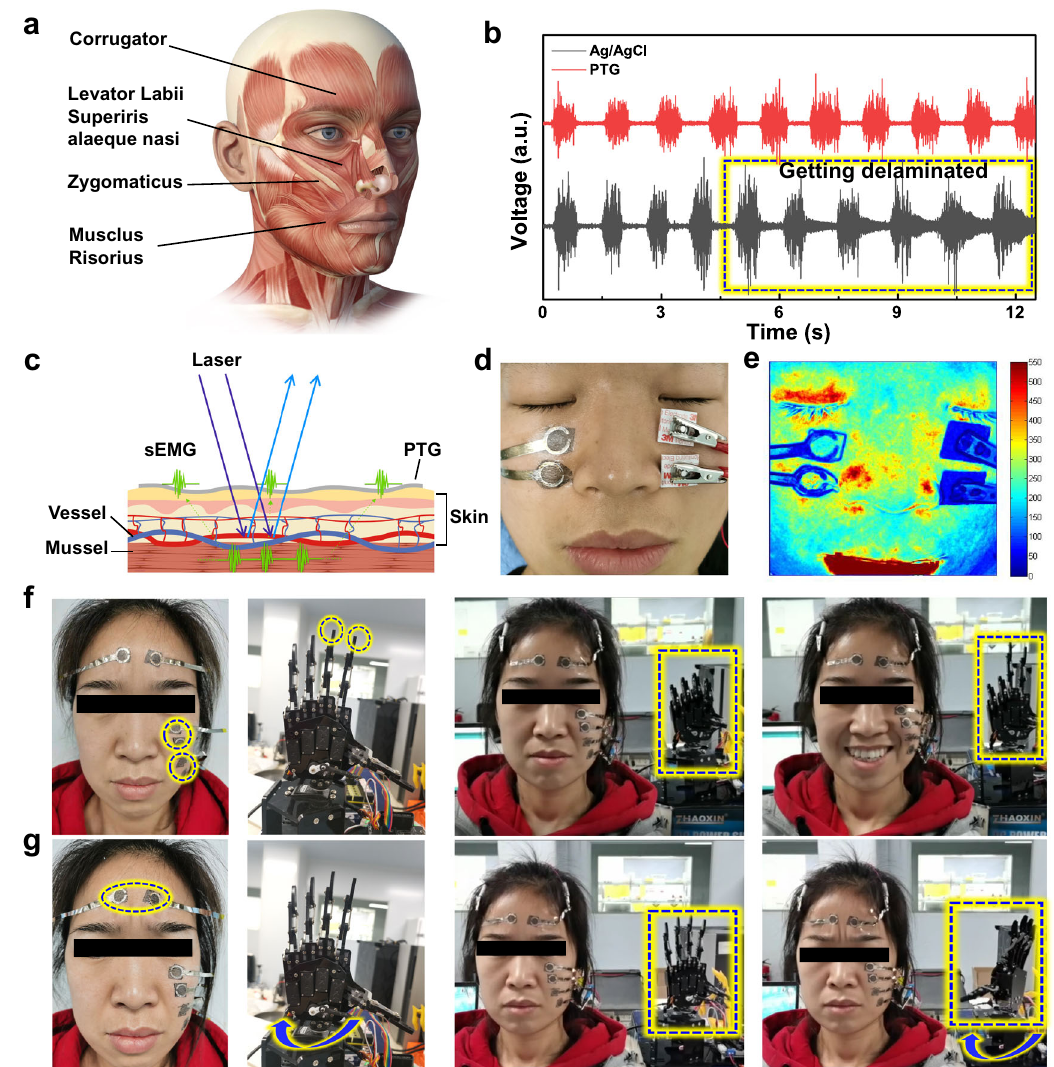
Fig. 6 Facial sEMG acquisition and facial expression-robot interaction. a A photo of facial expression muscles. b Facial sEMG measured by PTG (red) and Ag/AgCl (black) electrodes. PTG showed lower-motion artifact. c Schematic illustration of simultaneously monitoring sEMG and speckle imaging at the same location. d A photograph of PTG electrodes connected by metal for facial sEMG detection on levator labii superioris alaeque nasi on one side of the face with Ag/AgCl as control on the other side. Photo credit: Yan Zhao, State Key Laboratory of Digital Manufacturing Equipment and Technology, Beijing Normal University. e A laser speckle contrast imaging corresponding to (d), The blood perfusion under PTG electrodes can be measured by laser speckle contrast imaging technique (LSCI) whereas the blood perfusion under Ag/AgCl electrodes cannot be measured by LSCI. Photo credit: Yan Zhao, State Key Laboratory of Digital Manufacturing Equipment and Technology, Beijing Normal University. f Driving the robotic hand based on multi-channel facial sEMG signals extracted by PTG electrodes. Two PTG electrode pairs were adhered on zygomaticus and risorius to control the index and middle fi nger, respectively. Right photos showing that the robotic hand at the gesture of victory when the volunteer smiles. Photo credit: Yan Zhao, State Key Laboratory of Digital Manufacturing Equipment and Technology, Beijing Normal University. g PTG electrodes were adhered on corrugator to control the wrist of the robotic hand. Photos showing that the robotic hand rotates its twist when the volunteer extends and knits her brows Photo credit: Yan Zhao, State Key Laboratory of Digital Manufacturing Equipment and Technology, Beijing Normal